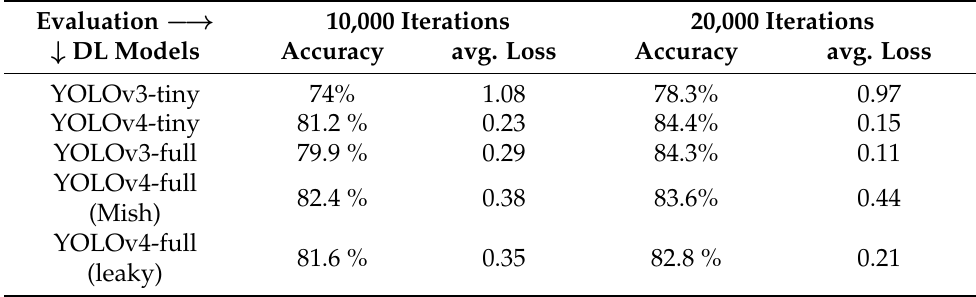
Table 1. Accuracy and average loss results of different DL models on different